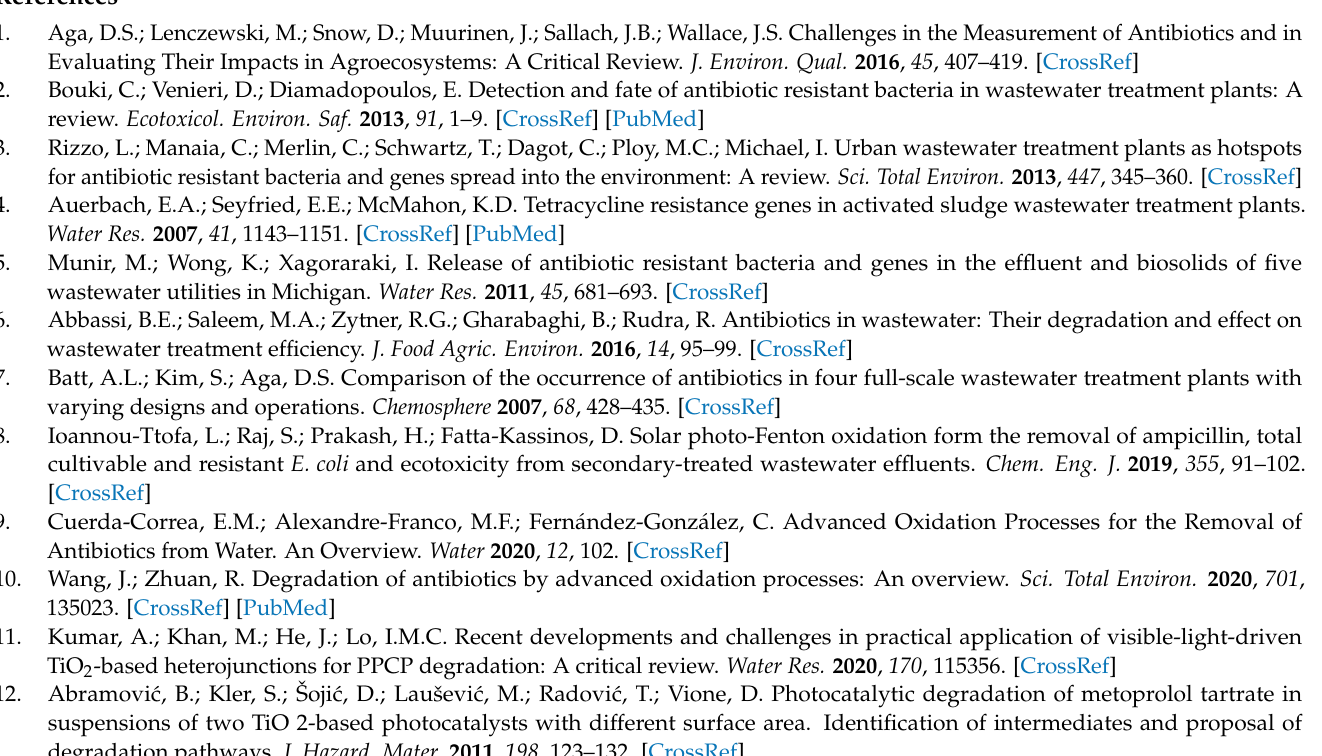
states and intermediates corresponding to the path 2 (Scheme in Figure 7), Figure S5: Changes of Gibbs relative energy along reaction coordinate and geometries of transition states and intermediates corresponding to the path 3 (Scheme in Figure 7), Figure S6: Changes of Gibbs relative energy along reaction coordinate and geometries of transition states and intermediates corresponding to the path 4 (Scheme in Figure 7), Figure S7: Changes of Gibbs relative energy along reaction coordinate and geometries of transition states and intermediates corresponding to the path 5 (Scheme in Figure 7), Figure S8: Changes of Gibbs relative energy along reaction coordinate and geometries of transition states and intermediates corresponding to the path 6 (Scheme in Figure